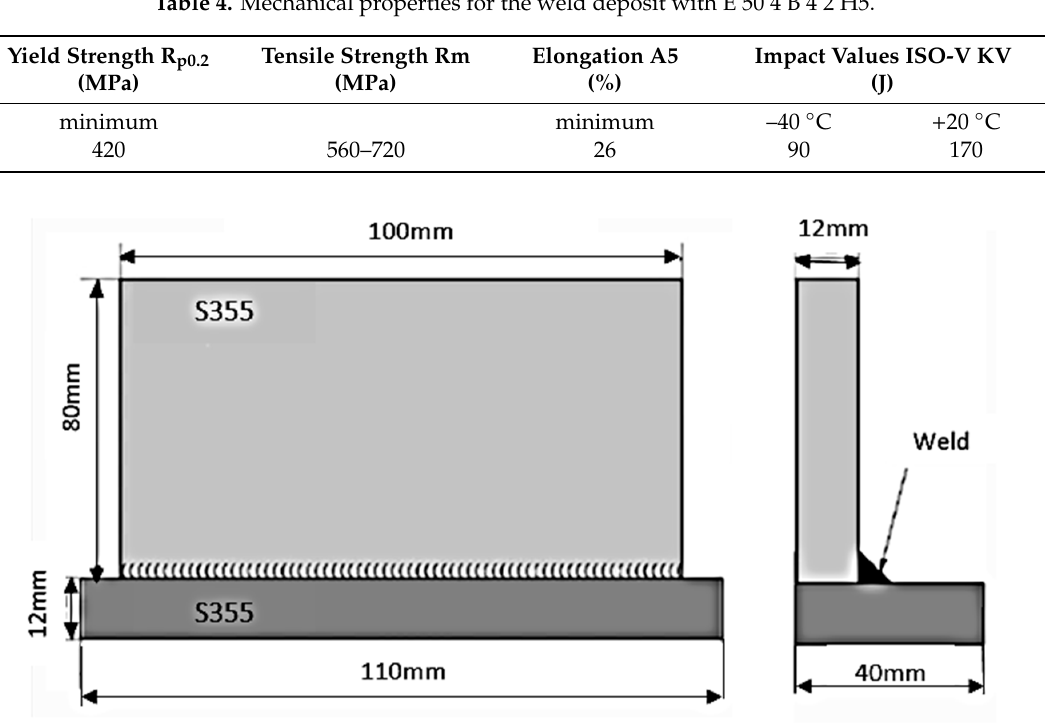
Figure 2. The order of deposition of the welding beads. After the deposition of the first welding layer formed by the welding seams 1, 2, 3, 4, 5, 6, 7 (Figure 2), the welding layer was polished after a geometry characterized by the connecting radius R1 (Figure 2), by this being aimed at increasing the heat absorption at the following layers compared to the previous ones, thus reducing the HAZ granulation adjacent to the previous layer. In fact, the aim is to overlap and position the successive welding seams, so as to produce a tempering of the